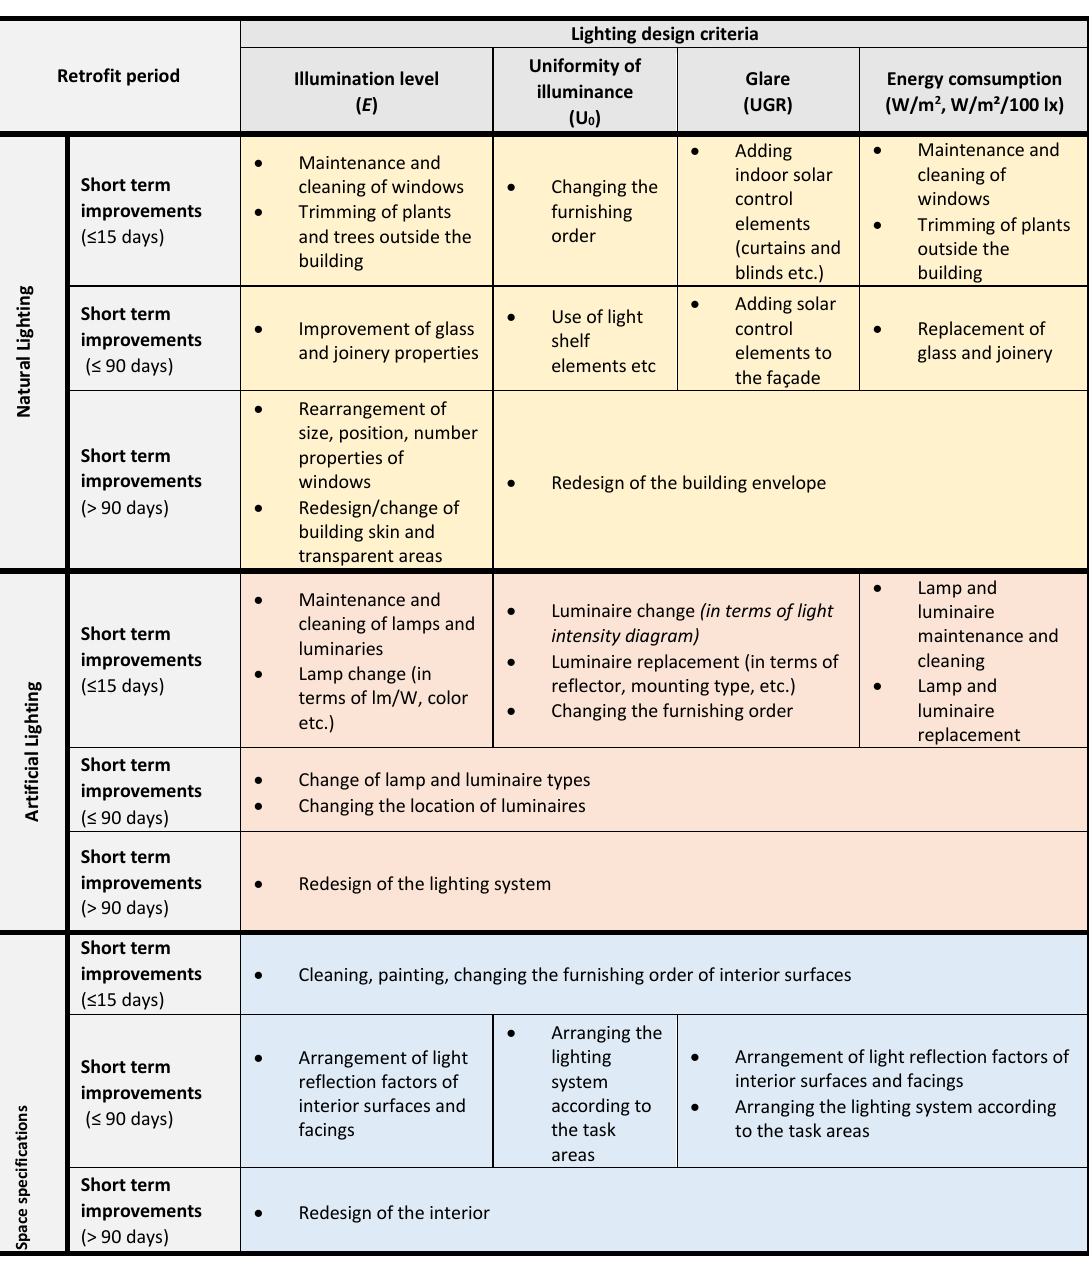
Table 5 Retrofit suggestions in terms of lighting design criteria and